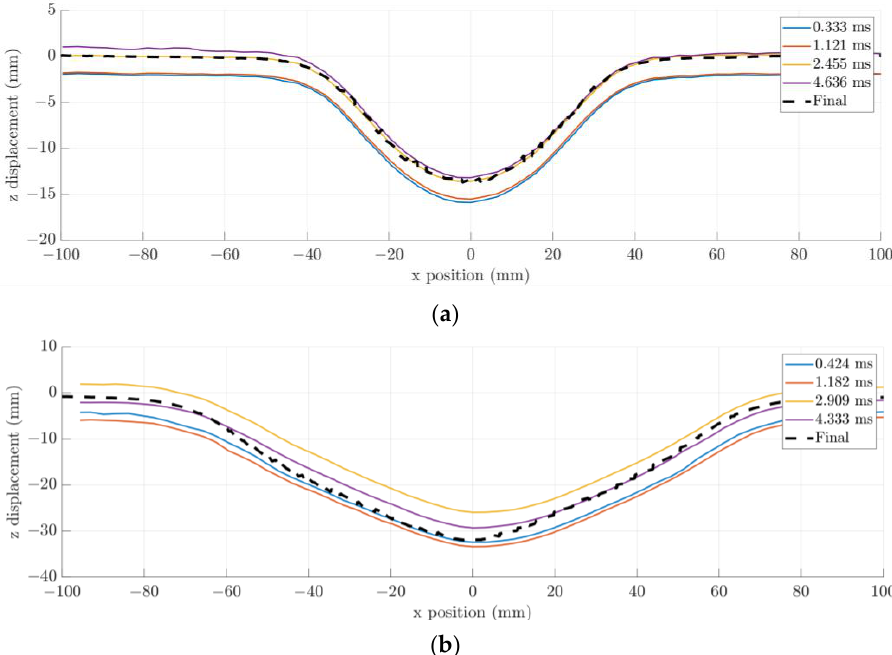
Figure 16. Transient deformation profiles at discrete times, along with a ridge, in 105° V-structures with ( a ) 10 g PE4, 32 mm tip radius, ( b ) 15 g PE4, 62 mm tip